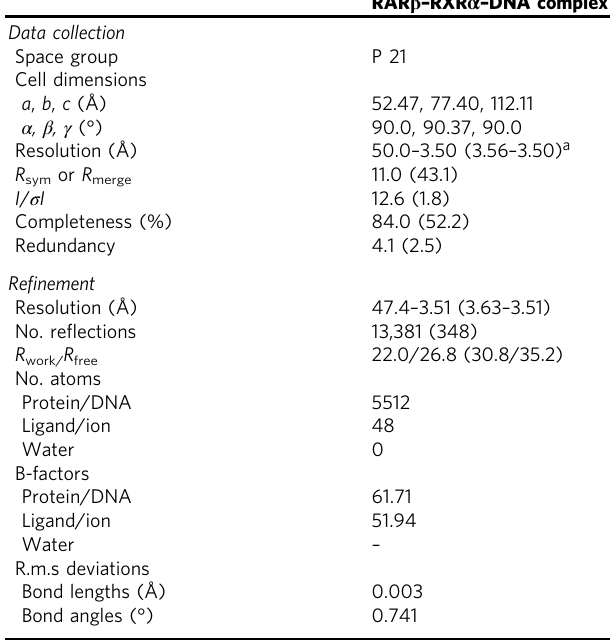
Table 1 Data collection and re fi nement